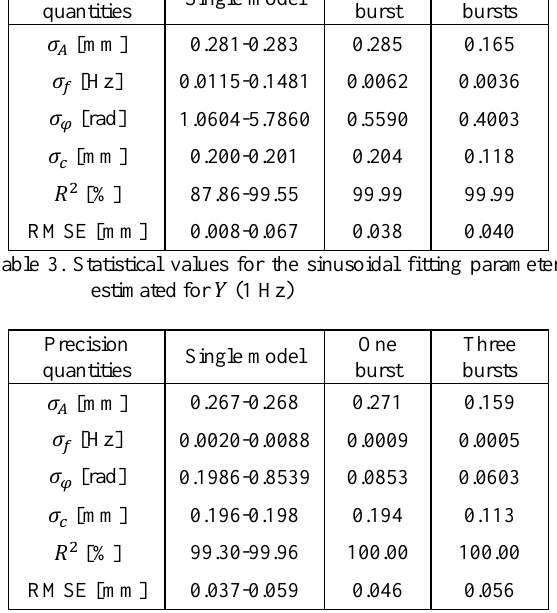
Table 4. Statistical values for the sinusoidal fitting parameters